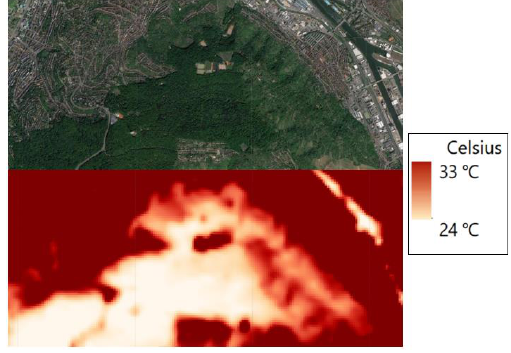
Figure 29: Land Surface Temperature in summer season vs. Landsat 8 image